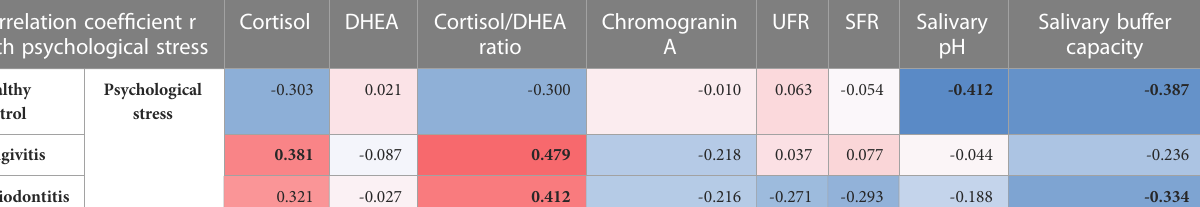
TABLE 5 Correlation between psychological stress and hormonal and salivary